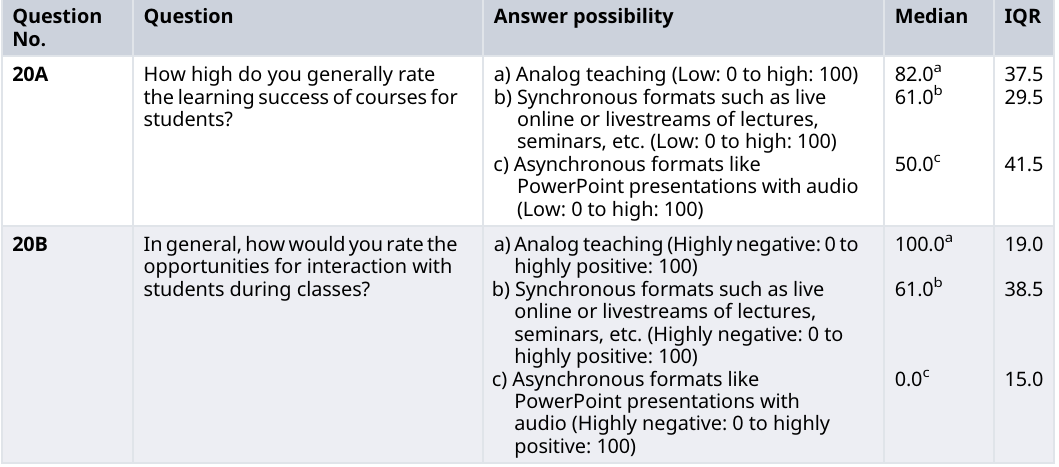
Table 2. Detailed results of VAS questions comparing different teaching formats using median and IQR (Interquartile rage) values. Superscript letters indicate significant differences between answer possibilities. Question